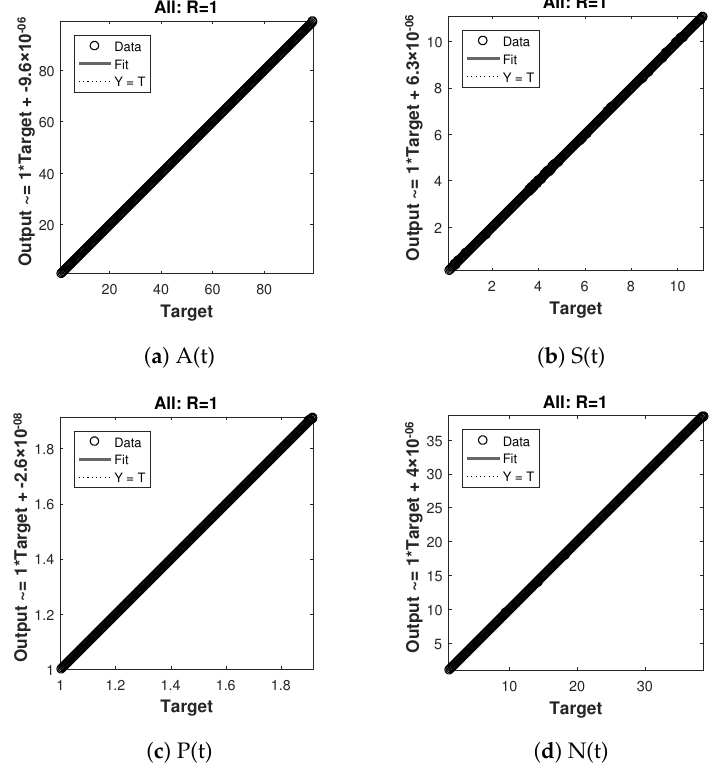
Figure 10. Regression analysis of nonlinear model of crop production for case 1. 20